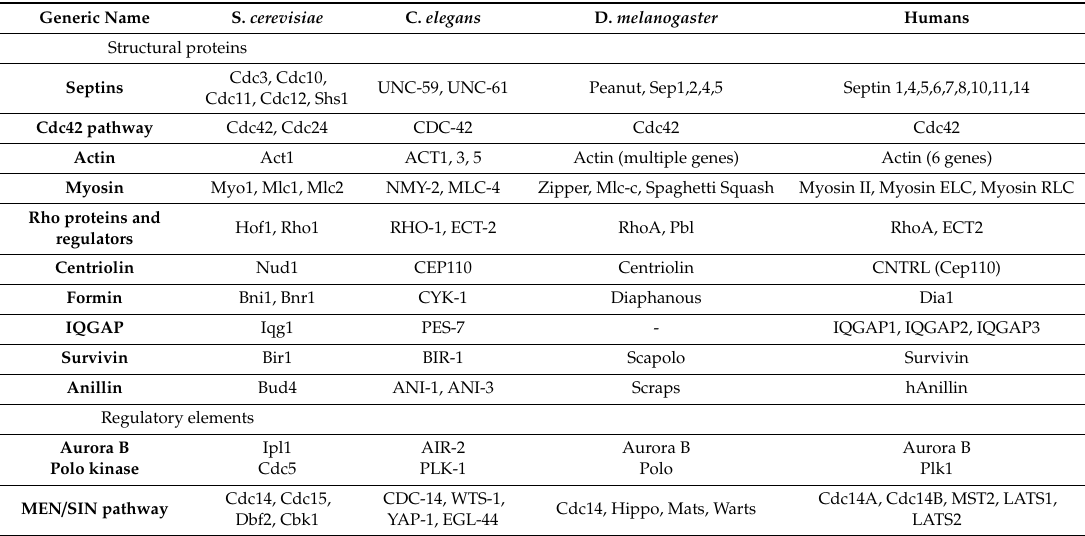
Table 1. Evolutionarily conserved proteins involved in